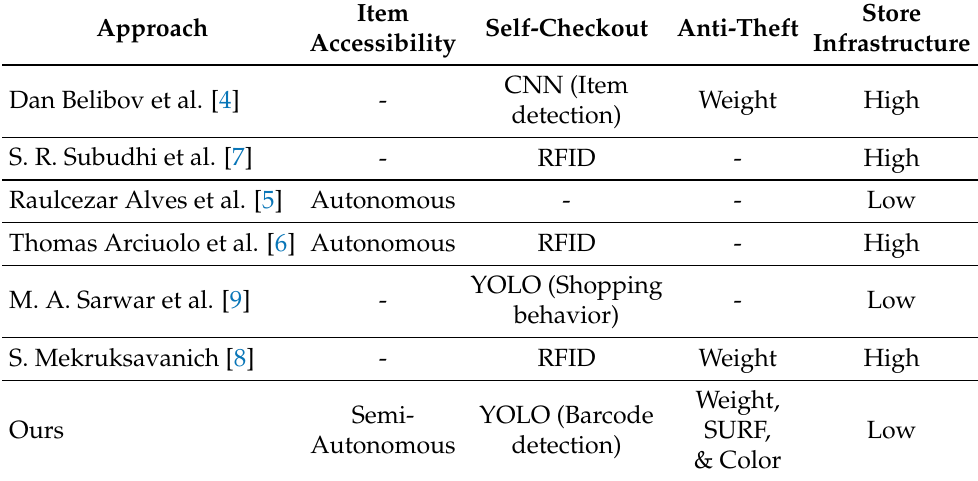
Table 1. Feature